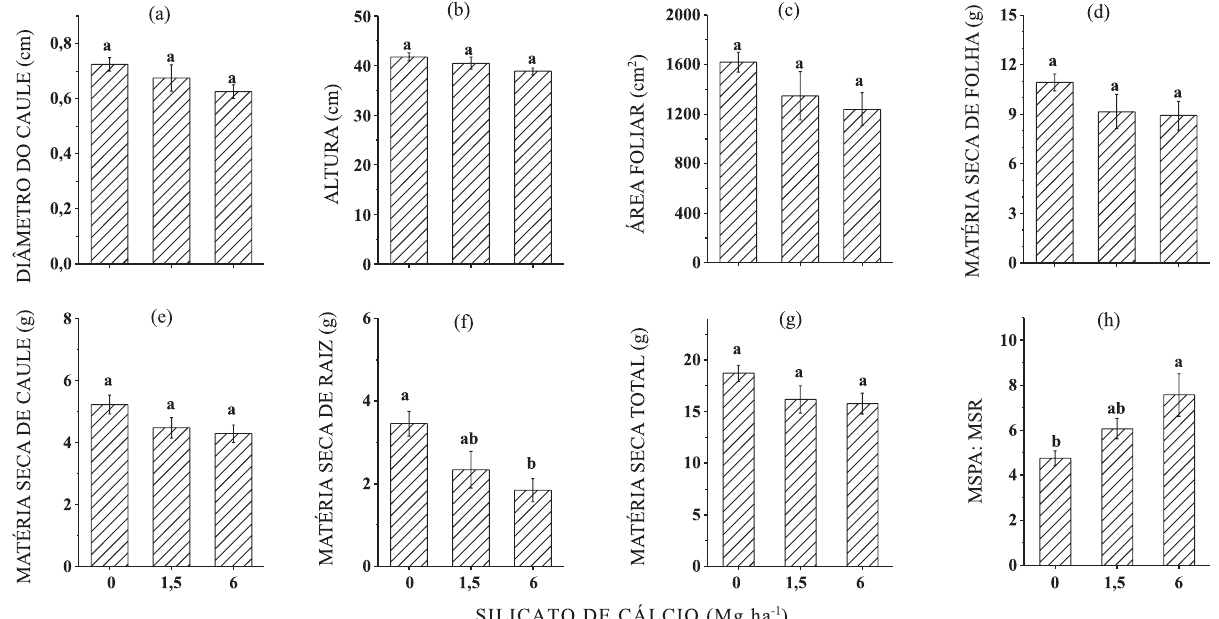
Figura 2. Diâmetro do caule (a), altura (b), área foliar (c), matéria seca de folha (d), de caule (e), de raiz (f) e total (g) e razão entre matéria de seca de parte aérea e sistema radicular (h) de cafeeiros após 130 dias da adubação silicatada. Cada histograma representa o valor médio de quatro repetições (± erro-padrão). Letras distintas entre tratamentos indicam diferença estatística pelo teste de Tukey (p